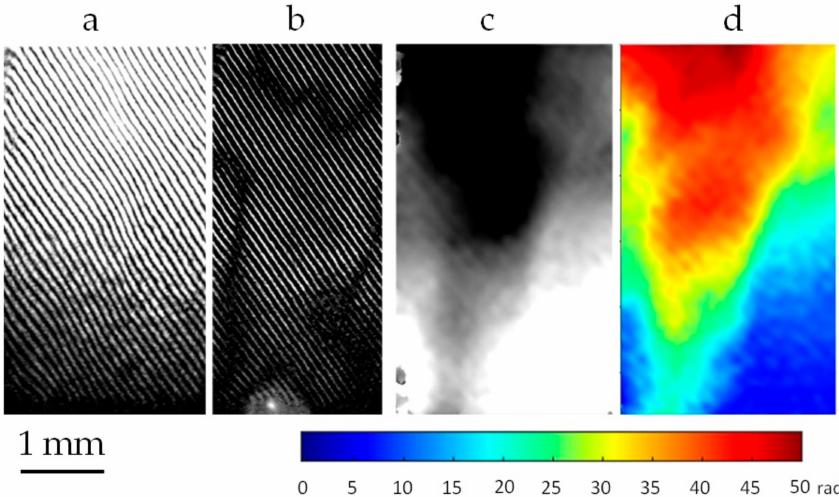
Figure 3. Gas-phase flow induced by the working laser at a power of 170 W: ( a ) initial interferogram before processing; ( b ) di ff erential interferogram—the di ff erence between the interference patterns of the unperturbed layer of air and the investigated gas-phase flow; ( c ) interferogram after spatial Fourier filtering; ( d ) pseudo-colored